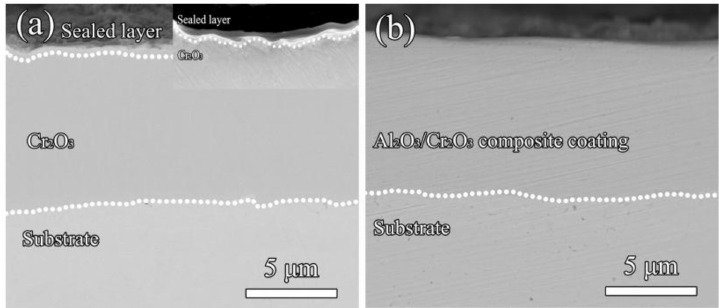
Figure 5. Cross-sectional back-scattered electron images of the sealed coating: ( a ) before heat treatment; ( b ) after heat treatment at 750 ◦ C. Insert is the corresponding SEM image.